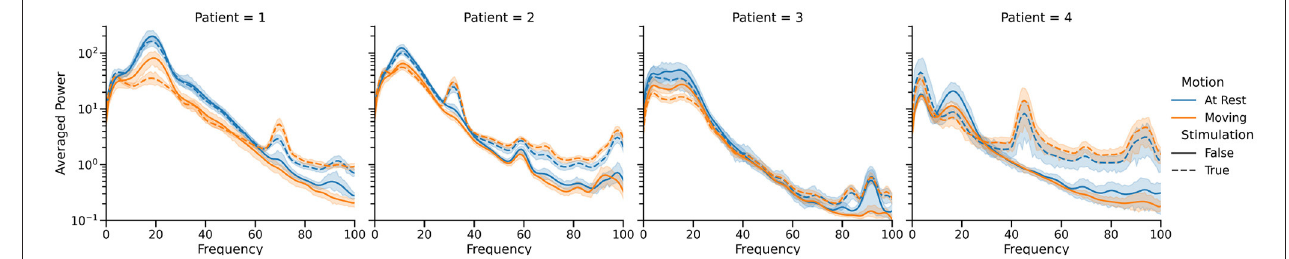
FIGURE 4 | Summary of the power spectral differences observed in cortical LFP recordings between the four states of primary interest for each of the four patients who participated in our study. Only single source recordings, performed at the hardware-specified 422 Hz, were used in this visualization, and movement periods were identified by manual inspection of the IMU data. Note the difference in spectral characteristics between the stim off (solid lines) and stim on (dotted lines) cases, as well as the drop in 12–30 Hz band power during movement (orange) compared to rest (blue). These spectra vary significantly between patients, necessitating training of classifiers for each patient